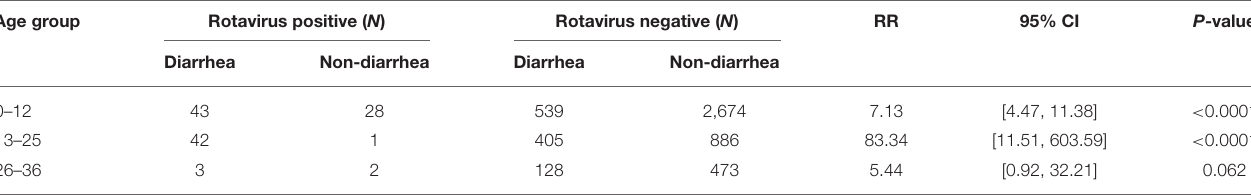
RR, Risk Ratio; N, total number of samples